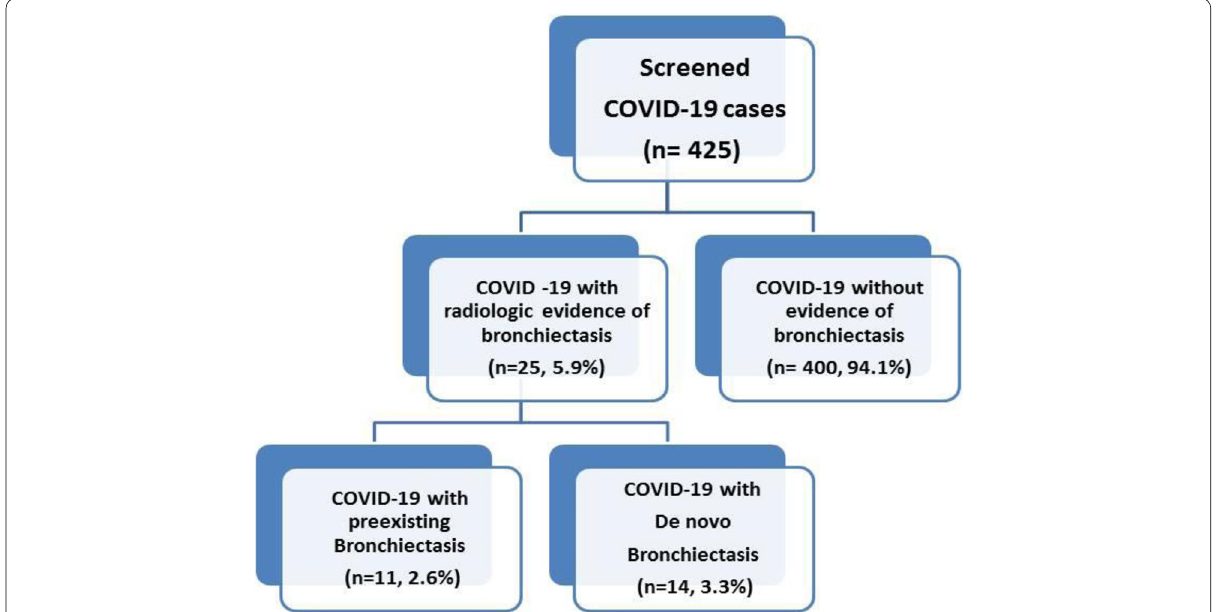
Fig. 1 Flowchart of screened COVID-19 cases included in the study ( n